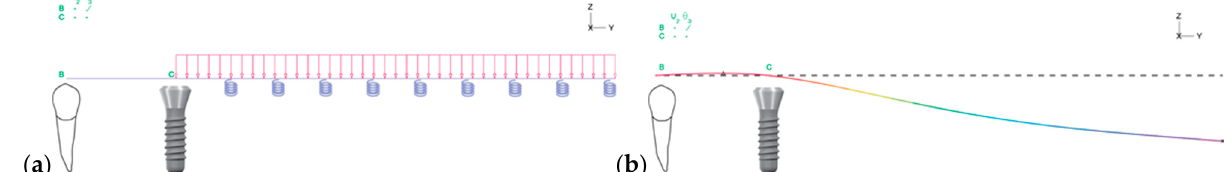
Figure 9. Representation of the IARPD PREMOLARS model as a cantilever beam with a non-rigid support in the abutment tooth and a rigid support in the implant. ( a ) Springs represent the vertical resistance promoted by the soft tissues and the occlusal load is distributed exclusively over the replacement teeth. ( b ) Schematic representation of the pattern of vertical displacement occurring in each of the extension bases of an implant-assisted Kennedy Class I RPD with mesial support as a modified cantilever beam Euler–Bernoulli